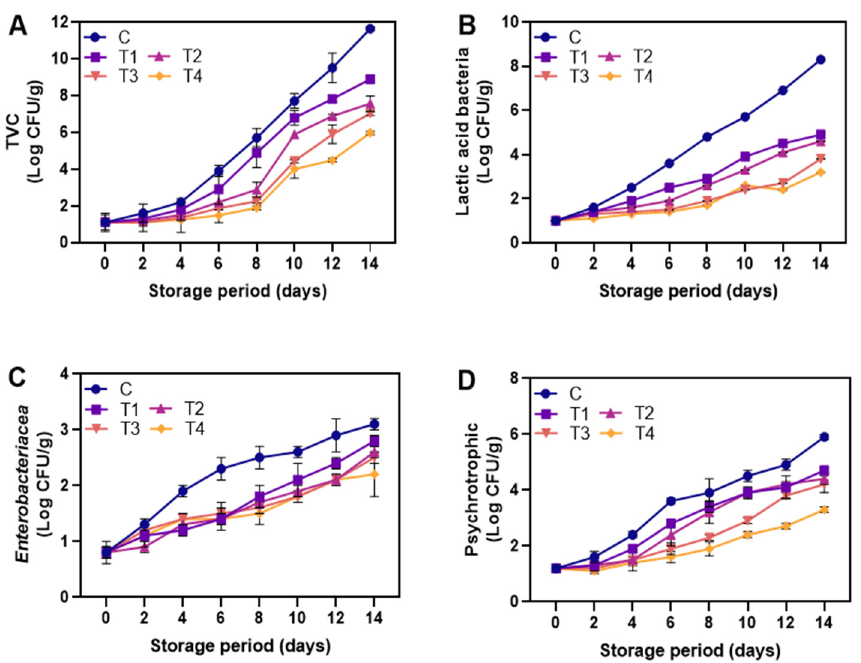
Figure 9. Changes in TVC ( A ), Lactic acid bacteria ( B ), Enterobacteriacea ( C ), and Psychrotrophic bacteria ( D ) of the shrimps coated with different coating during storage of 14 days at 4 °C. C: shrimp dipped in distilled water as control; T1: shrimp coated with alginate coating; T2, T3, and T4: shrimp coated with 0.5, 1.0, and 1.5% LPE, respectively.